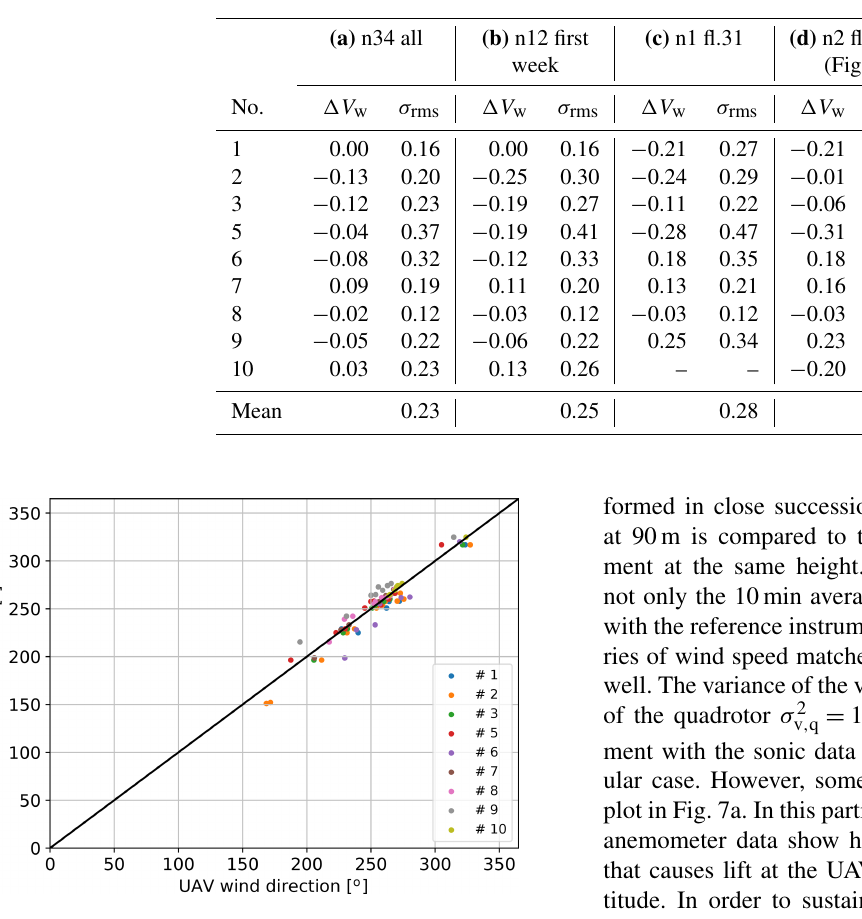
Table 3. Accuracy of wind speed measurements in meters per second (ms − 1 ) for different calibration data using only pitch offset applied to the validation dataset of 12 flights from the second week. Data used for calibration: (a) all possible drone tower flight patterns (34 flights); (b) only flights from the first week (12 flights); (c) only one single flight with flight number 31; (d) two flights with flight number 31 and 56.